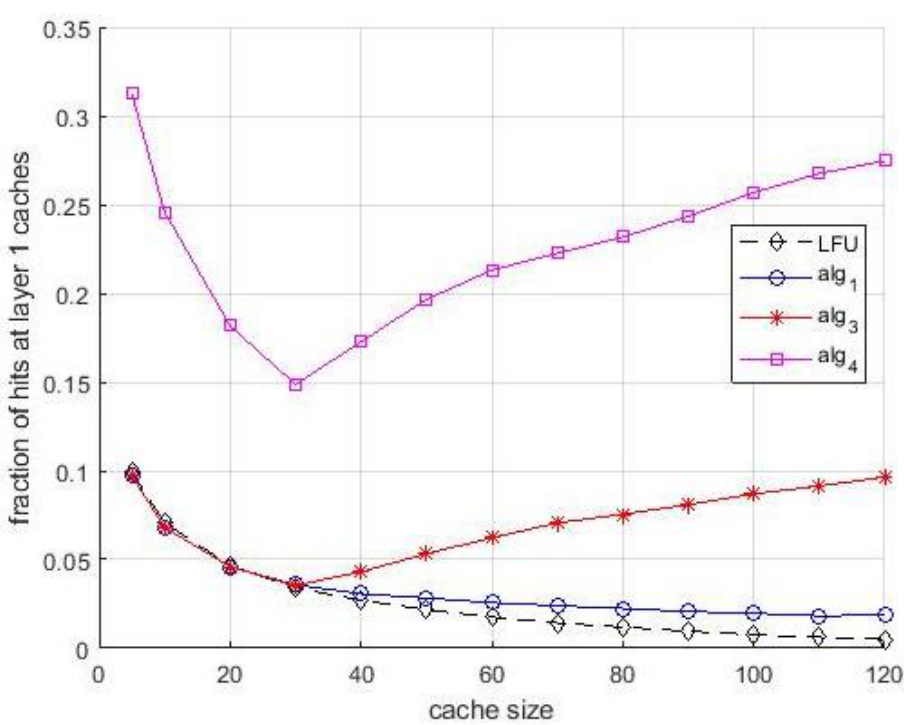
Figure 10. Fraction of hits at 1st layer caches, case 2, N =